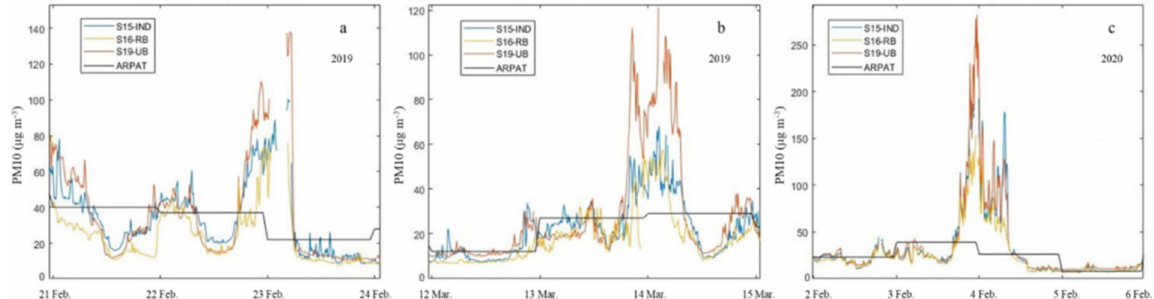
Figure 6. Detection of PM 10 concentration peaks at high-frequency (10-min) scale by the S15-IND, S16-RB, S19-UB stations as compared to the daily values observed by the ARPAT reference station. Examples of further insights by the AirQino stations with respect to the ARPAT station may be observed during both ( a , b ) no co-location period and ( c ) co-location period.